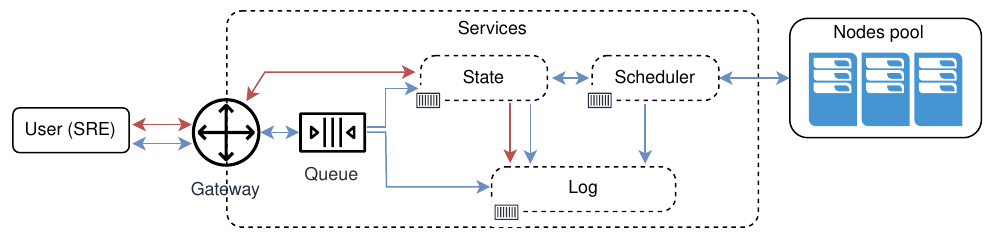
Figure 5. High overview of the services model.